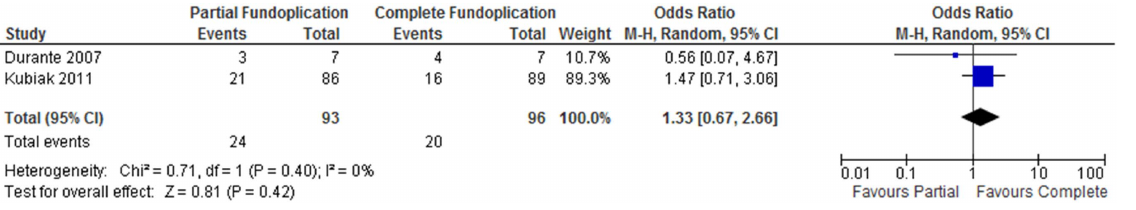
Figure 2. Recurrence of reflux symptoms following partial versus complete fundoplication (RCT).